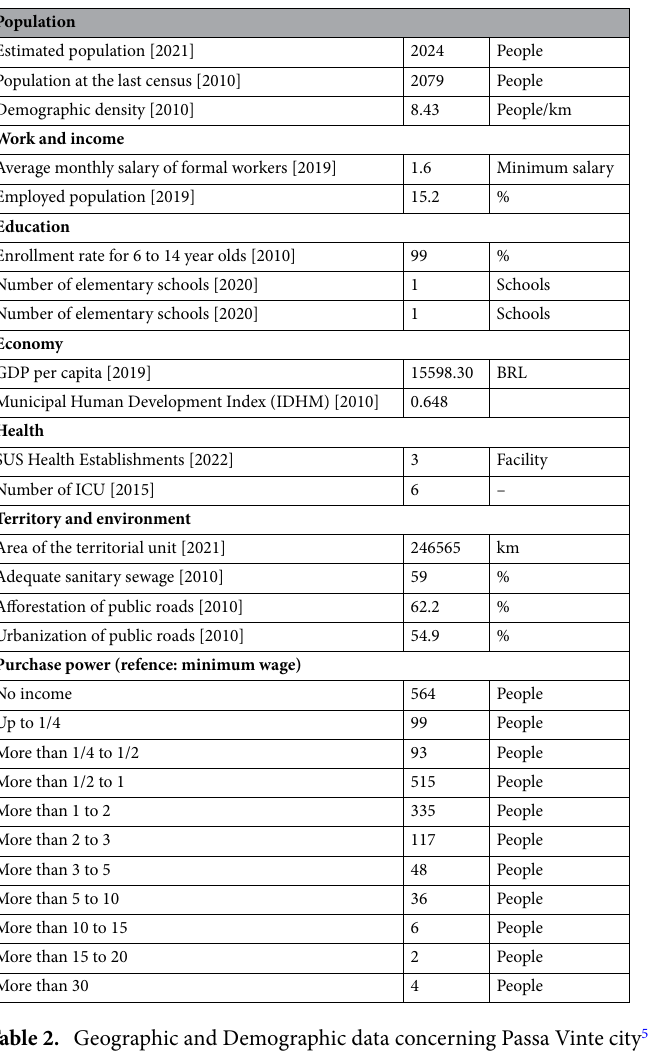
Table 2. Geographic and Demographic data concerning Passa Vinte city 5 .